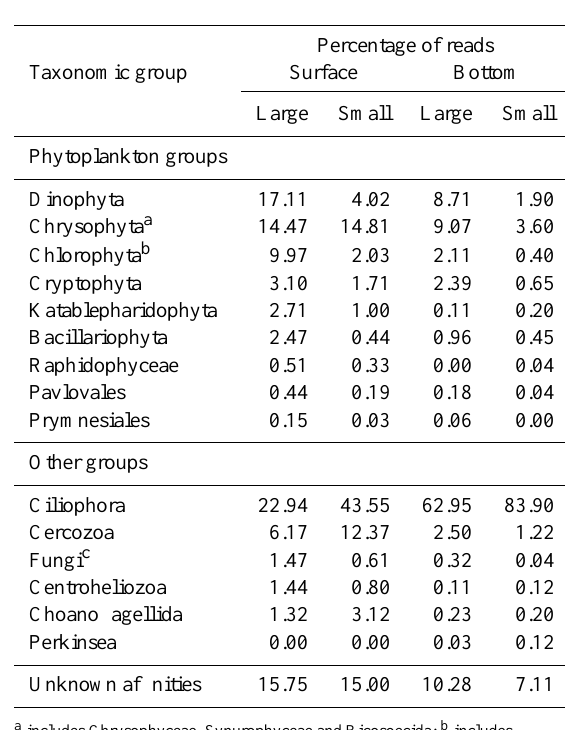
Table 4. RNA sequence analysis of eukaryotes in samples from permafrost thaw lake SAS2A, sampled in 2012. Each value is the % number of reads of the total for each sample (total number of reads minus rotifer sequences). The large fraction was retained on a 3µm filter and the small fraction was on a 0.2µm filter after passing through the 3µm